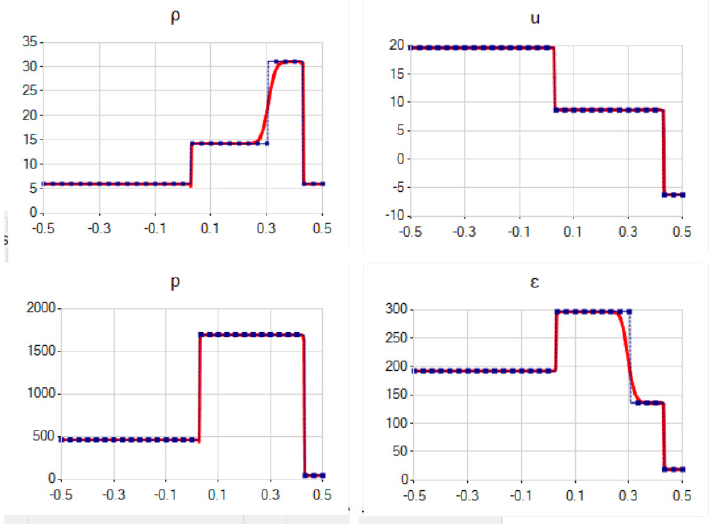
Figure 4. Test 3. Solutions for α = 0 . 3, β = 0 . 5 and N = 600